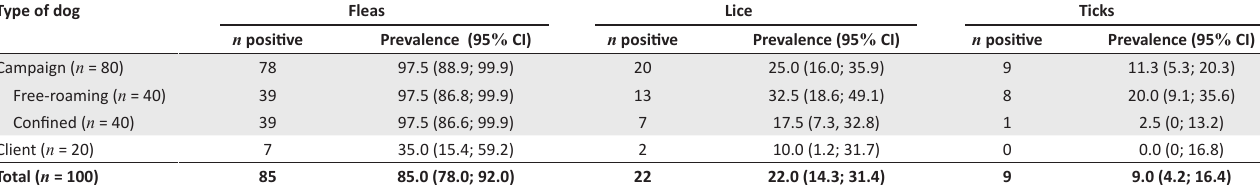
TABLE 1: Prevalence (with confidence intervals) of ectoparasites in dogs in Lilongwe, Malawi, September–October 2014. Type of